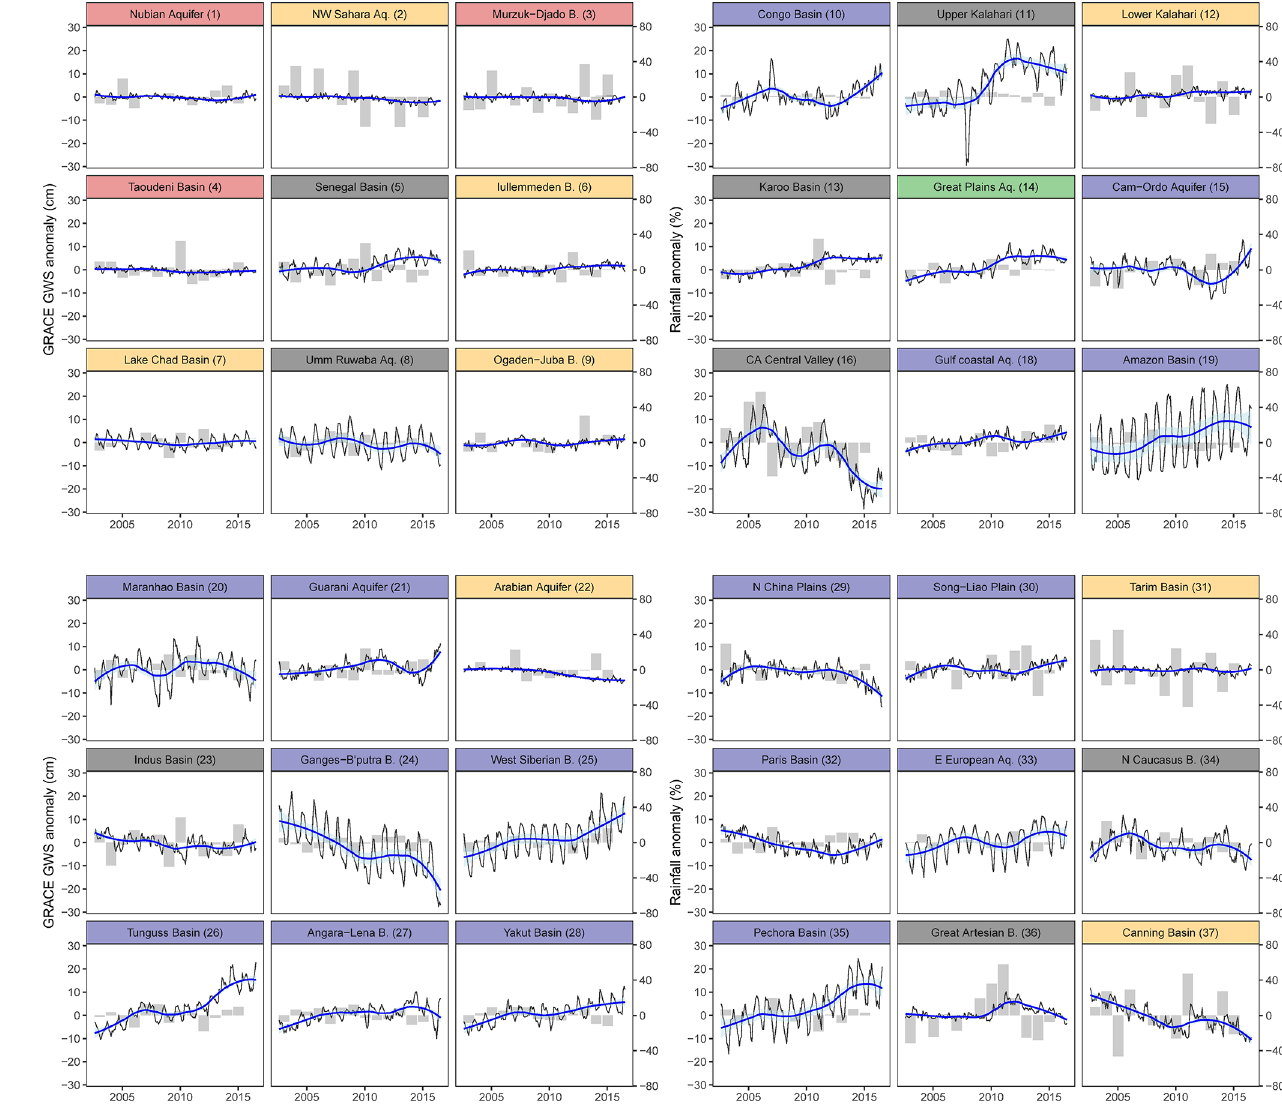
Figure 5. Monthly time series data (black) on ensemble GRACE (cid:49) GWS for 36 large aquifer systems with a fitted non-linear trend line (Loess smoothing line in thick blue) through the time series data; GRACE (cid:49) GWS for the remaining large aquifer system (High Plains Aquifer System, WHYMAP aquifer no. 17) is given in Fig. 2. The shaded area in semi-transparent cyan shows the range of the 95% confidence interval of the fitted Loess-based non-linear trends; light grey bar diagrams behind the lines on each panel show the annual precipitation anomaly (i.e. percentage deviation from the mean precipitation for the period of 1901 to 2016); banner colours indicate the dominant climate of each aquifer based on the mean aridity index shown in the legend in Fig.